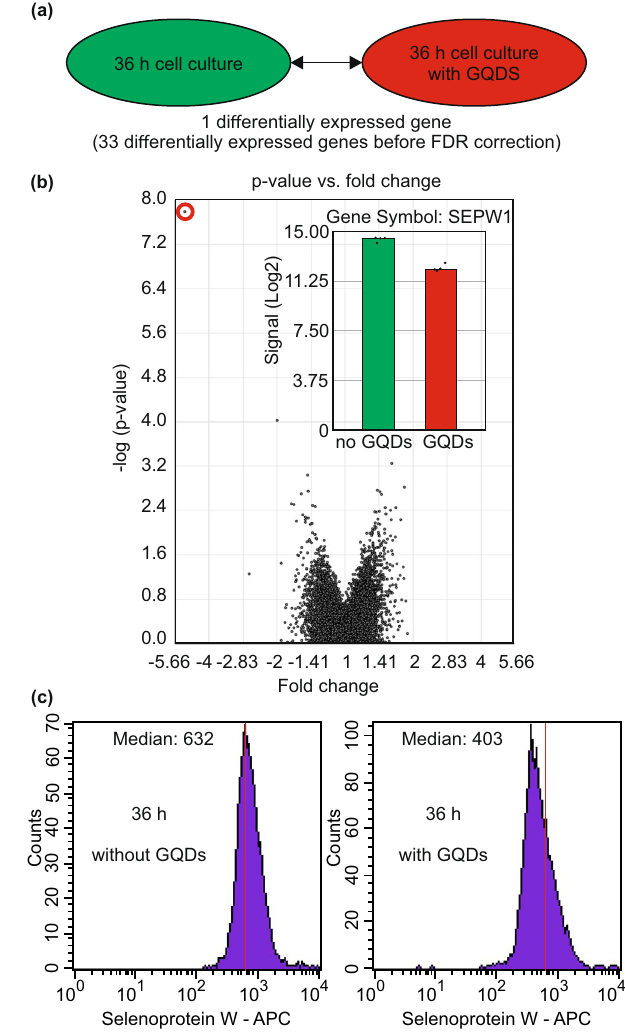
Figure 7. ( a ) Comparison of the transcriptome of CD34 + cells following cultivation under the two conditions for 36 hours. Only the SEPW1 gene showed a significant differential expression. ( b ) Volcano plot for all genes (SEPW1 is labeled with a red circle in the upper left corner) and sample signals for the SEPW1 gene (inset). ( c ) Measurement of the intracellular amount of Selenoprotein W following 36 h of cultivation without GQDs (left) and with GQDs